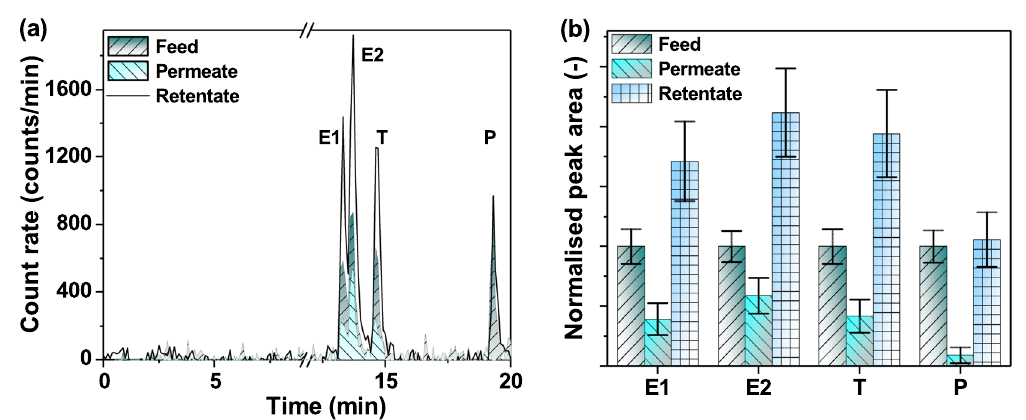
Figure 6. Nanofiltration membrane experiments with the mixtures of E1, E2, T, and P (100 ng/L each). ( a ) UHPLC-FSA radiochromatograms, ( b ) the normalised peak area for each analyte in feed, permeate and retentate samples. The permeate was collected after filtration of 700 mL volume. The error bar was estimated via error propagation approach as presented in Supplementary